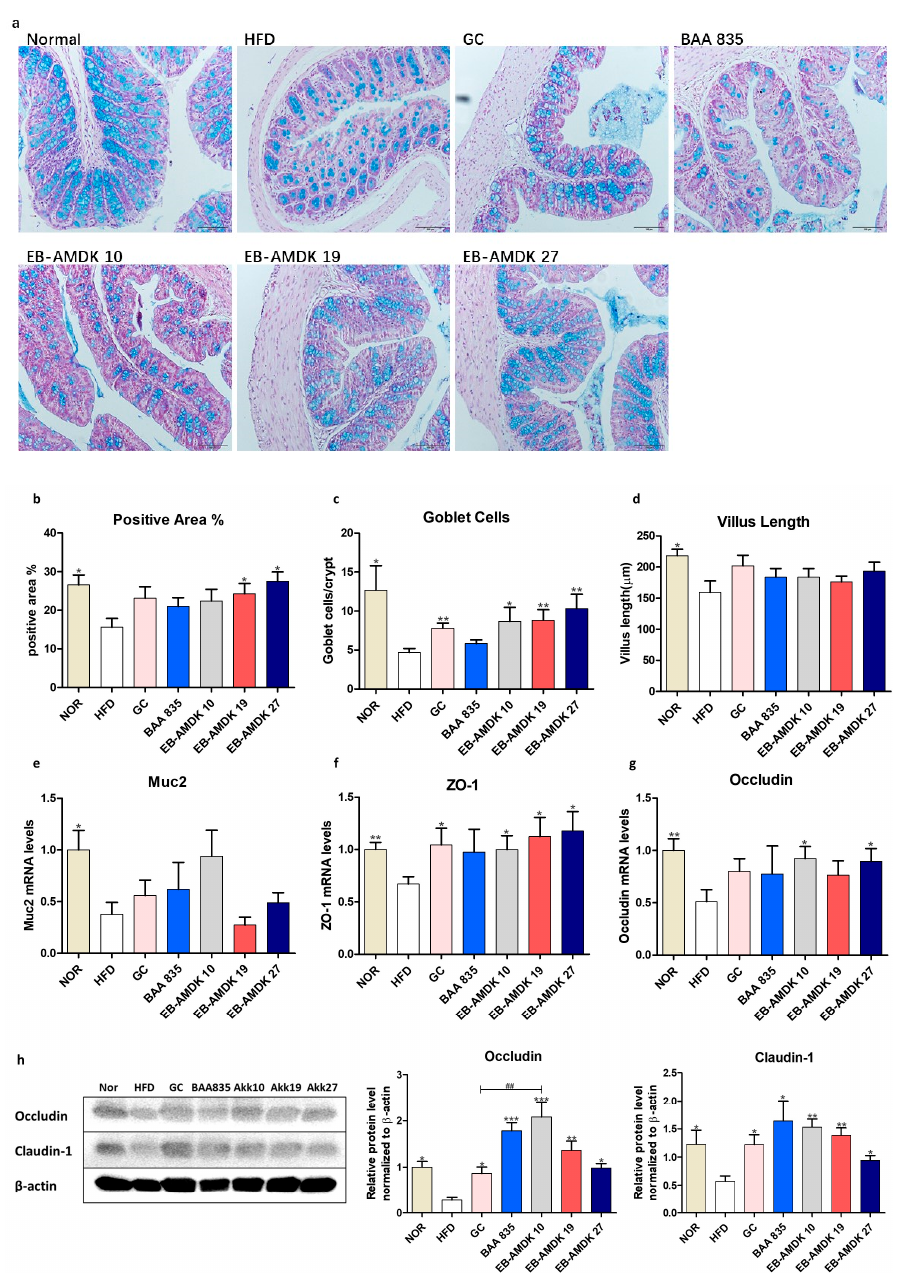
Figure 7. A. muciniphila administration improved the intestinal structure and barrier integrity of the HFD-fed mice. ( a ) Representative microscopic images demonstrating Alcian blue (AB)-staining of the colonic tissue sections of mice from different experimental groups at a magnification of 200 × , ( b ) proportion of AB-positive area (%), ( c ) number of goblet cells and ( d ) length of a villus in colonic tissue sections ( n = 3 per condition, scale bar, 100 µm). Representative mRNA expression of ( e ) Muc2, ( f ) ZO-1 and ( g ) Occludin in the intestine tissue from mice ( n = 9–12 mice/group). ( h ) The protein expression of the intestine tissue ( n = 4 mice/group). Data are represented as the mean ± SEM. Statistics were performed with one-way ANOVA or Student’s t-test. * p < 0.05, ** p < 0.01 and *** p < 0.001 versus the HFD group. ## p < 0.01.